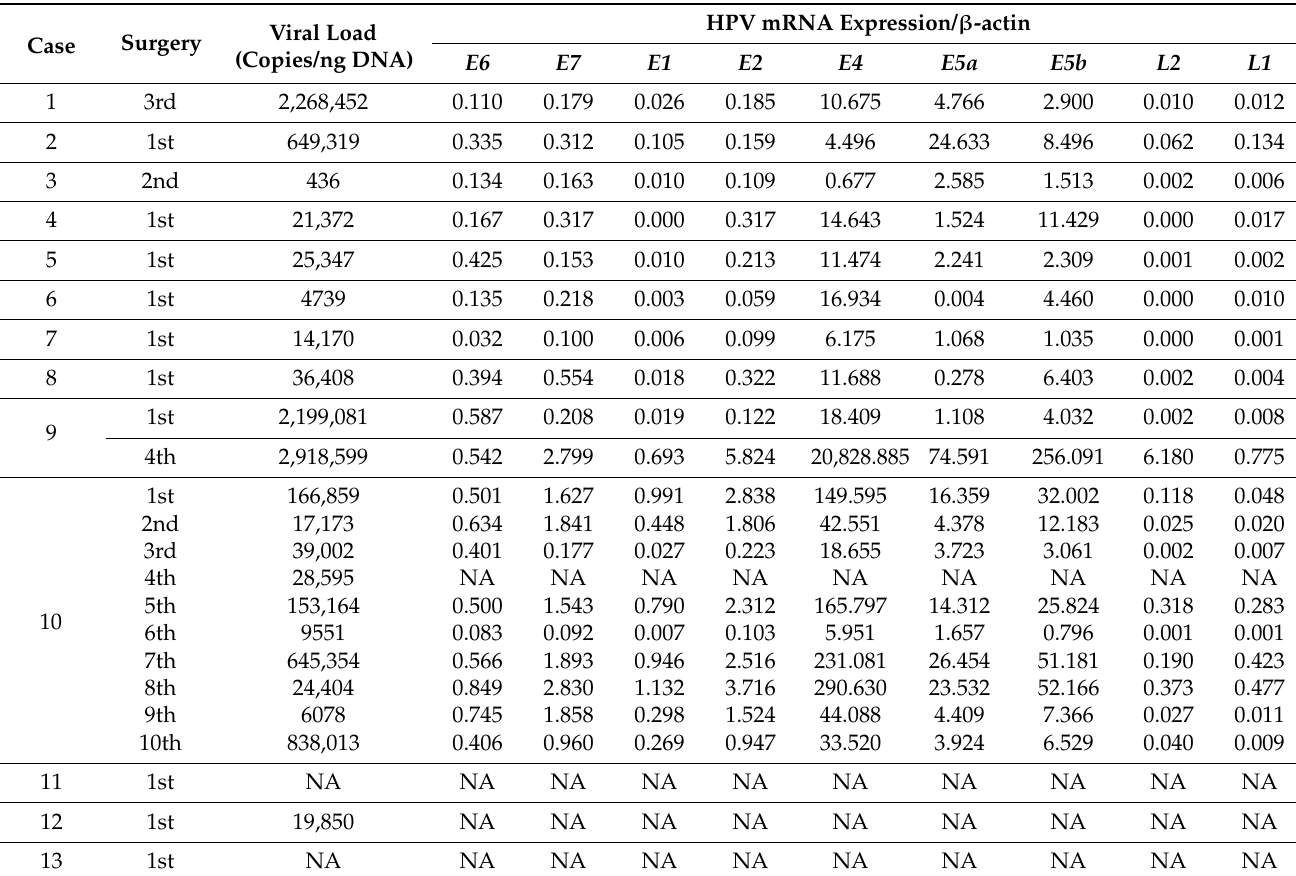
Table 2. Viral load and mRNA